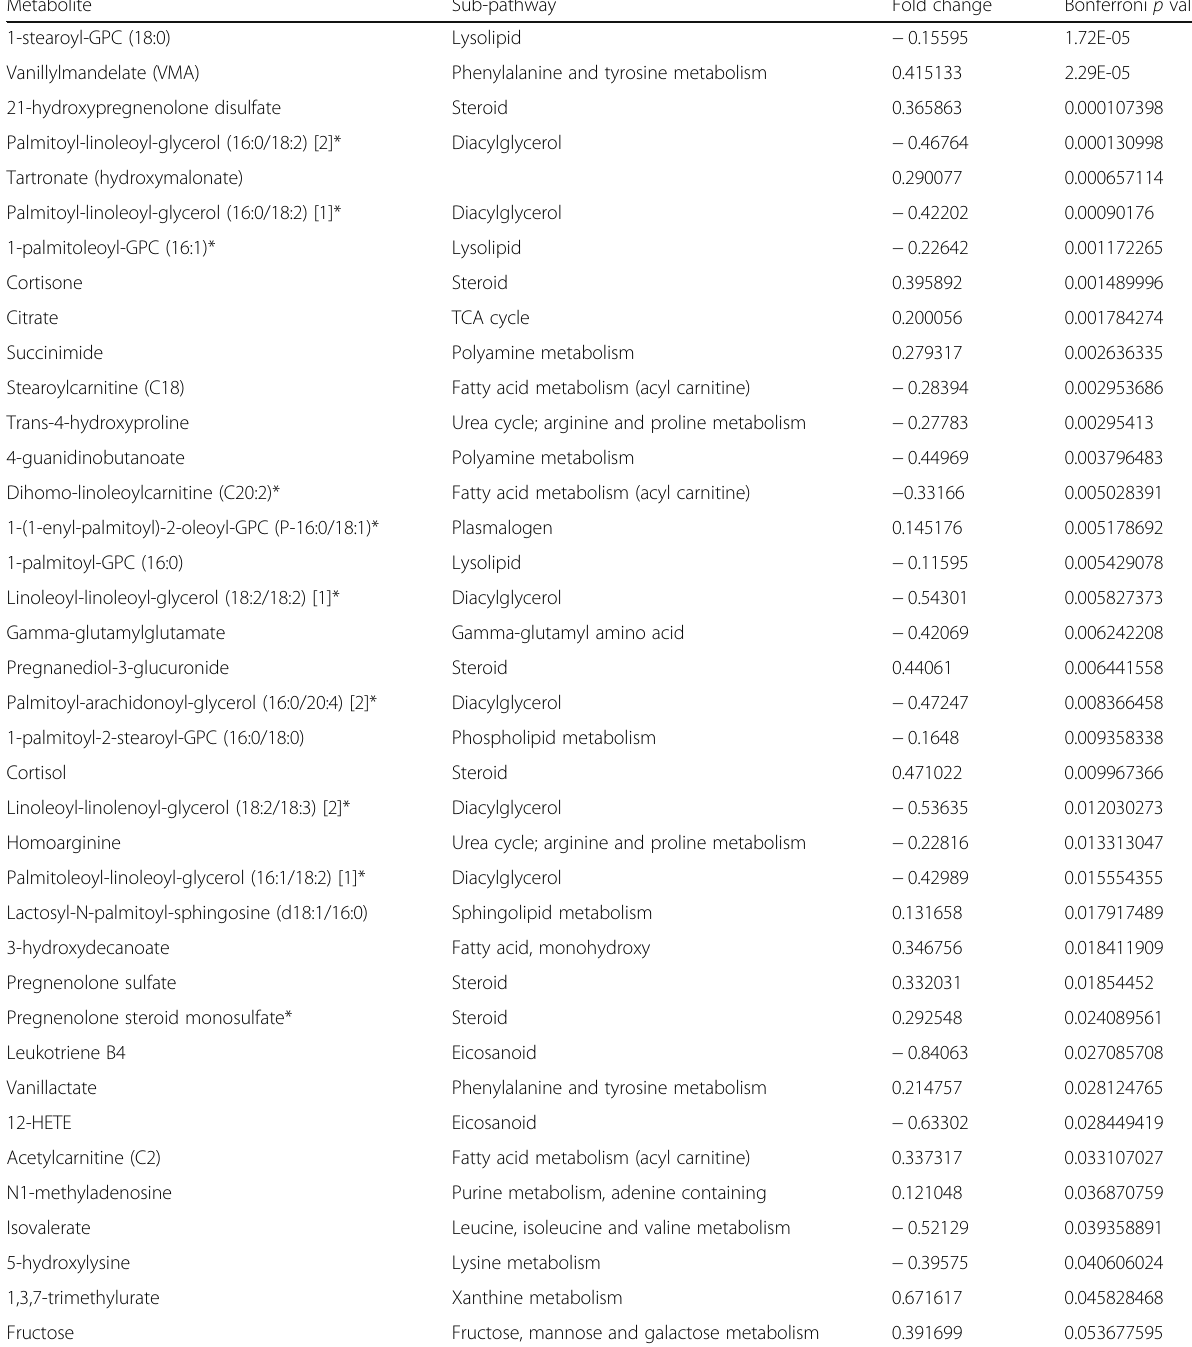
Table 2 Metabolites differentiating between moderate- and high-endurance athletes (Bonferroni significance) Metabolite Sub-pathway Fold change Bonferroni p